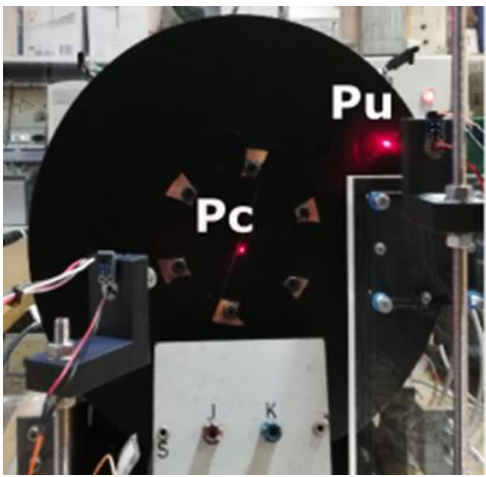
Figure 20. Situation of the points Pc and Pu, located in the centre and in the periphery, respectively, where the radial gradient of temperatures in the disk is measured.